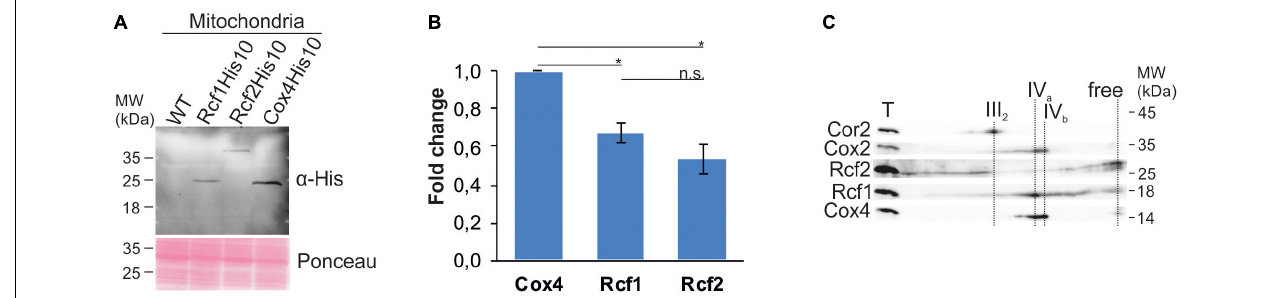
FIGURE 3 | Rcf1 and Rcf2 are no stoichiometric subunits of cytochrome c oxidase. (A) and (B) Steady-state protein levels of His-tagged Rcf1, Rcf2 and the cytochrome c oxidase subunit Cox4. Decoration against the epitope of the His-tag showed 30% lower protein levels of Rcf1 and Rcf2 compared to Cox4. The proteins were extracted from mitochondria purified from cells grown in YPG, 30 ◦ C. The Western blot signal was quantified using the software ImageJ (the standard errors were calculated from a sample size of n = 3). (C) BN-PAGE analysis followed by 2D SDS-PAGE, Western blot and immuno decoration of wild-type mitochondria solubilized in 2% DDM showed that Cox4 solely comigrated with cytochrome c oxidase, while Rcf1 and Rcf2 comigrated additionally with other complexes. T, total; III 2 , dimer of bc 1 complex; IV a and IV b , forms of cytochrome c oxidase. n.s., P > 0.05; ∗ P ≤ 0.05; ∗∗ P ≤ 0.01; ∗∗∗ P ≤ 0.001; ∗∗∗∗ P ≤ 0.0001.